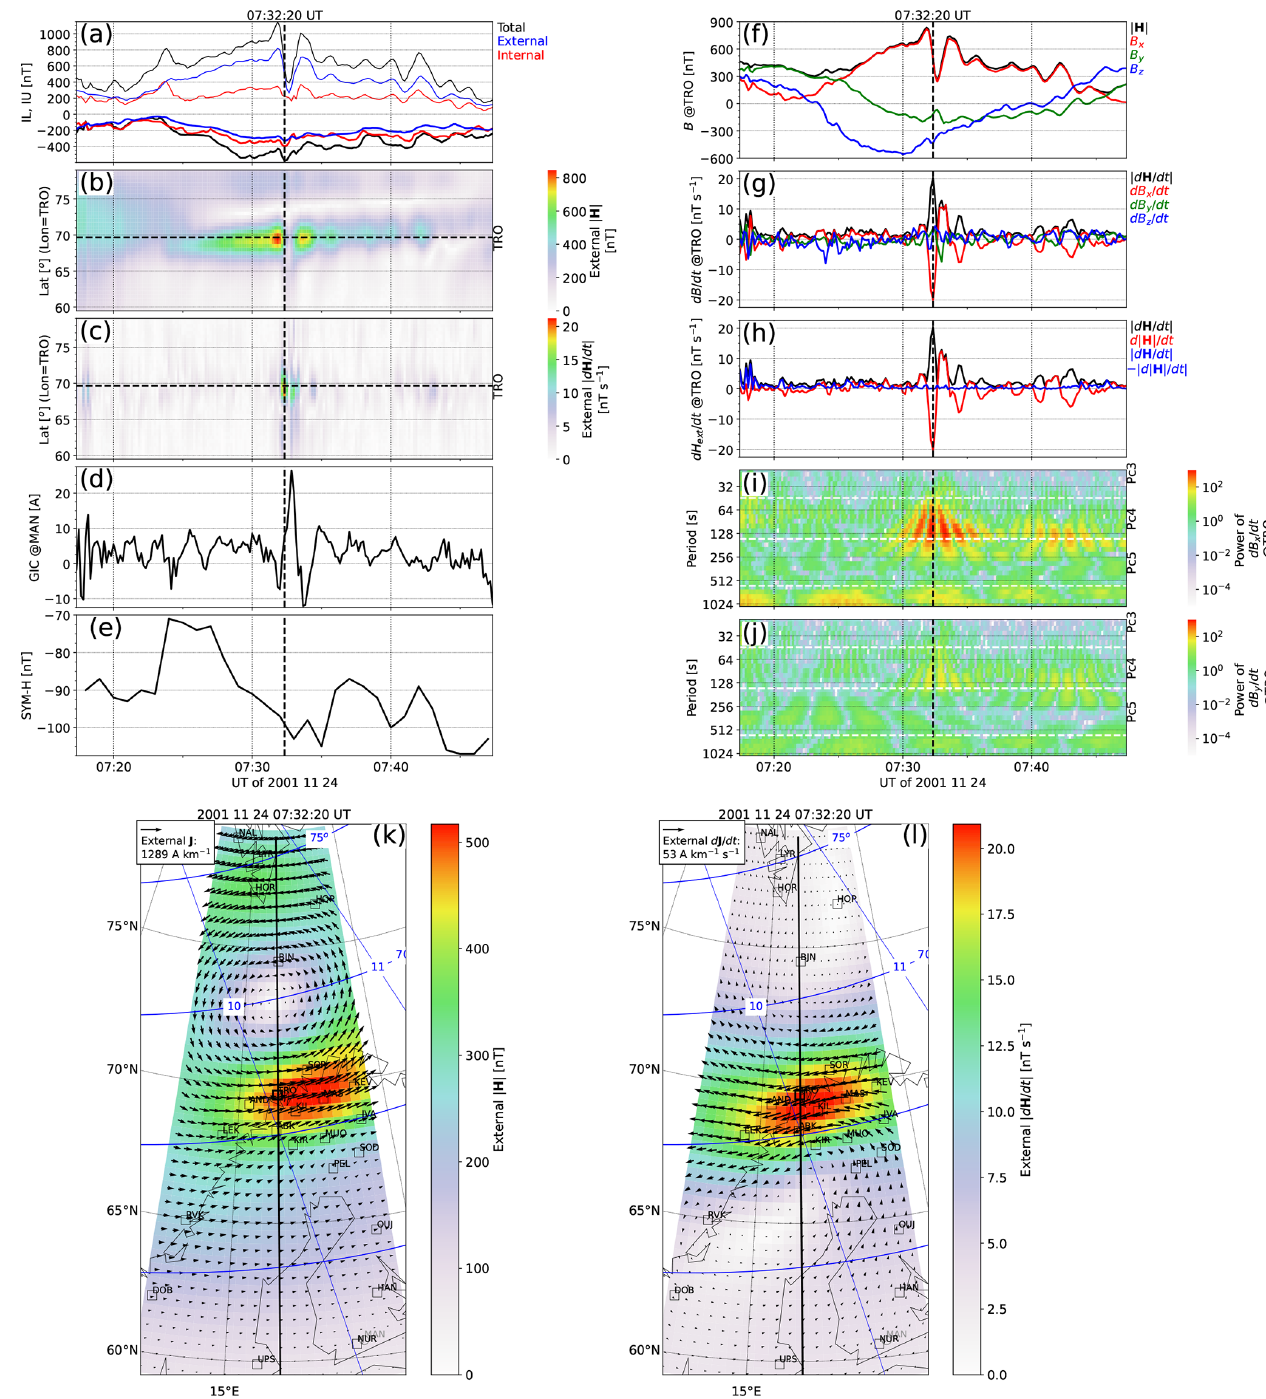
Figure 7. Data in a format similar to Fig. 5 ± 15min around the event on 24 November 2001 at